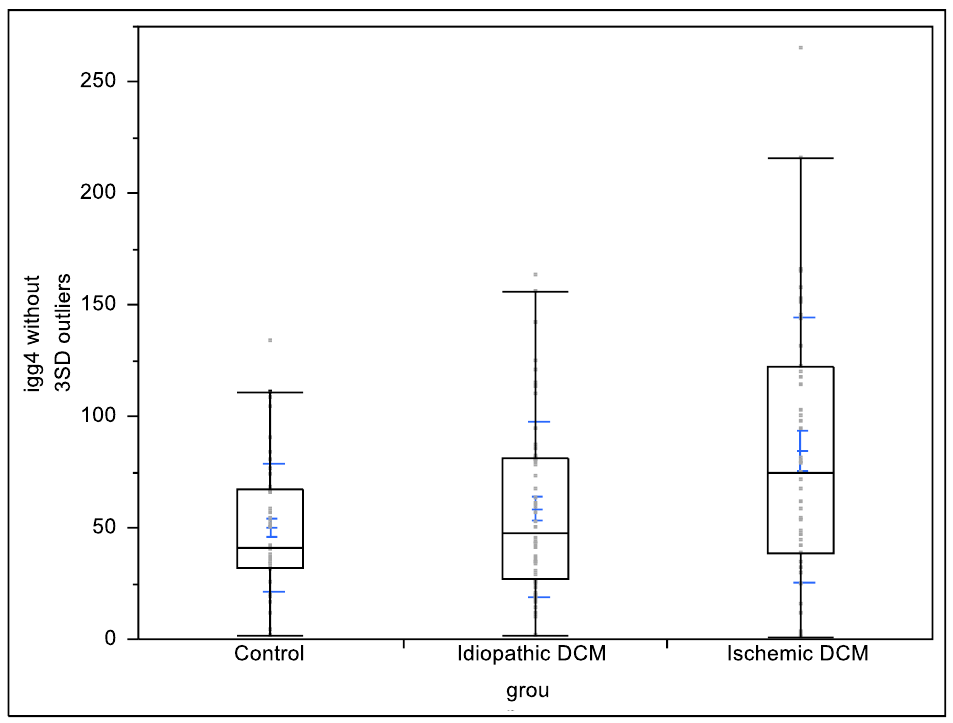
Figure 1. Comparison of IgG4 levels between patients with ischemic cardiomyopathy, non-ischemic cardiomyopathy, and control group. Black boxes represent interquartile ranges; blue bars represent mean and standard deviations. Table 2. Comparison of total IgG and IgG4 subclass between patients with ischemic cardiomyopathy, non-ischemic cardiomyopathy, and control group.